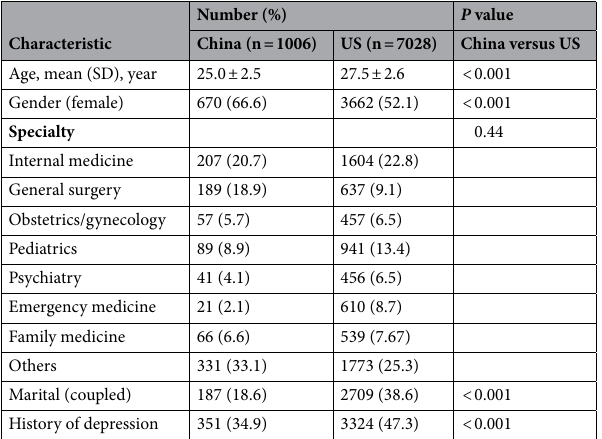
Table 1. Sample Demographic Characteristics at Baseline. Number (%): frequency and percentage. n total number, SD standard deviation, P value by t-test and chi-square